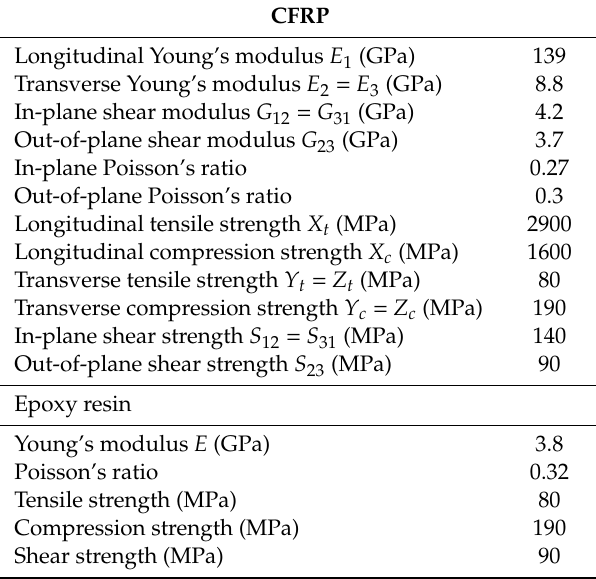
Table 1. Properties of CFRP and epoxy resin.